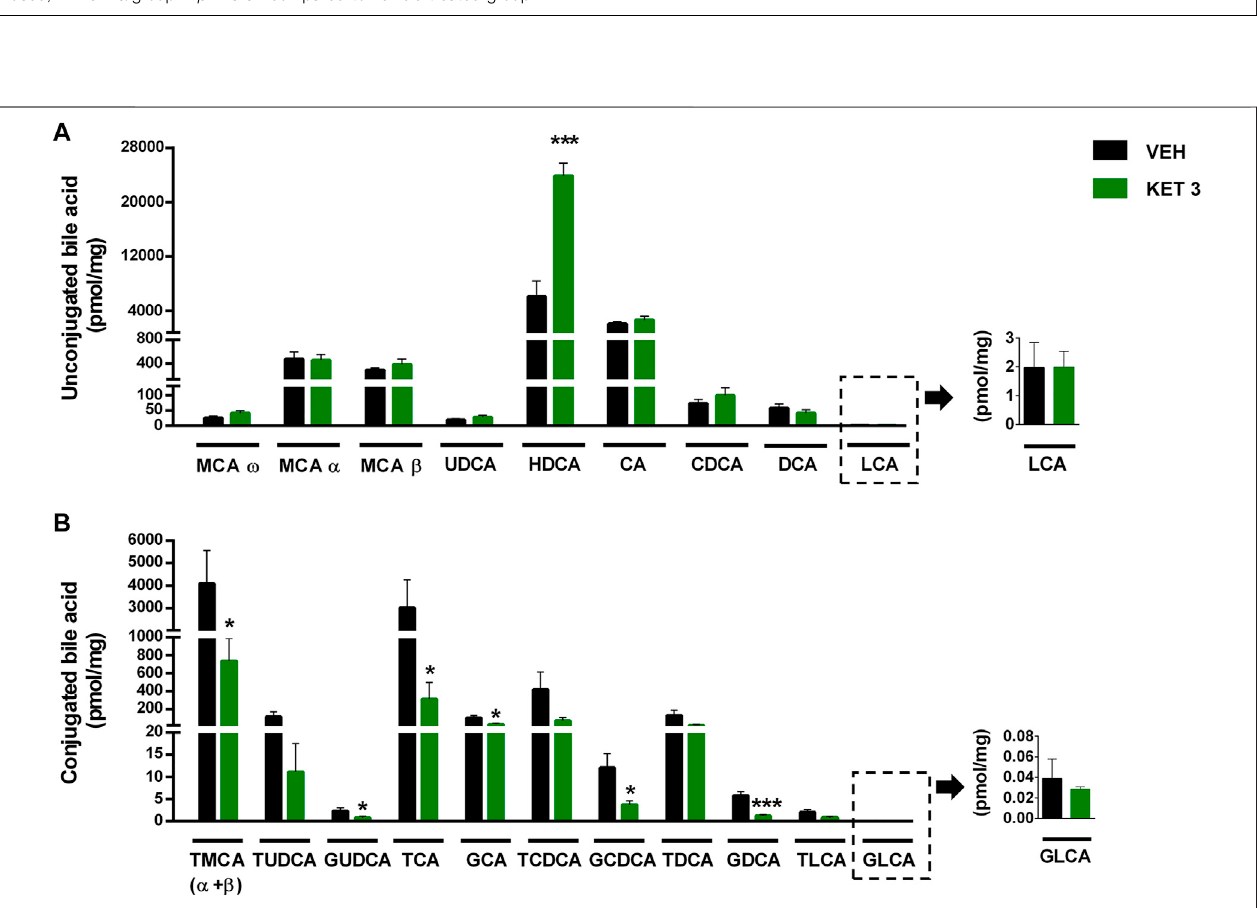
FIGURE 7 | The effect of four-week vehicle (VEH) or ketorolac treatment (KET, 3 mg/kg) on the small intestinal concentration of (A) unconjugated and (B) conjugated bile acids. Bile acids are ordered by increasing hydrophobicity. Bars indicate the mean + SEM, for statistical analysis Student ’ s t test was used, n (cid:2) 9 – 10/ group. * p < 0.05, *** p < 0.001 compared to vehicle-treated group. MCA, muricholic acid; UDCA, ursodeoxycholic acid; HDCA, hyodeoxycholic acid; CA, cholic acid; CDCA, chenodeoxycholic acid; DCA, deoxycholic acid; LCA, lithocholic acid; T, respective taurine conjugates; G, respective glycine conjugates.